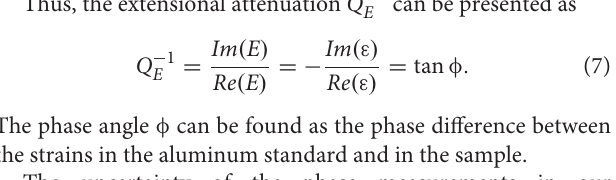
piezoelectric actuator and strains in the rock are controlled by three semiconductor strain gauges (type KSP-6-350-E4, Kyowa Ltd). One gauge attached to the aluminum standard is oriented in the axial direction and the other two, attached to the sample, are are connected with electric bridges (BCM-1 Wheatstone Bridge, Omega Engineering) via a feedthrough